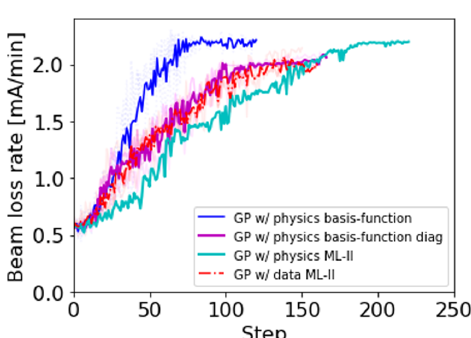
FIG. 4. Simulated optimization using RBF kernel for the data- informed Gaussian process with ML-II kernel learning (red), physics-informed Gaussian process with ML-II (cyan), and physics-informed Gaussian process basis-function, either with full kernel including correlations (blue), or diagonal kernel (magenta). The ML-II kernels are diagonal as